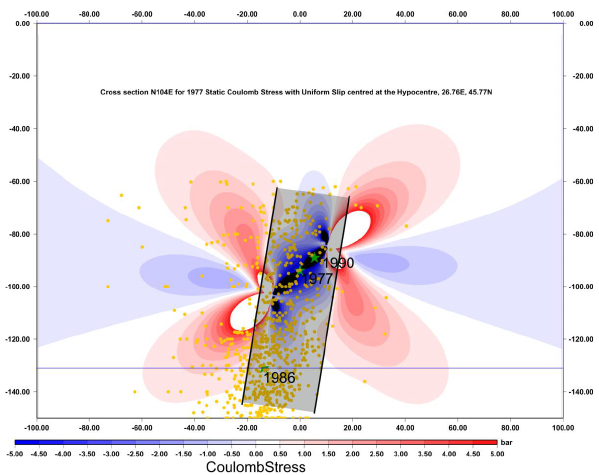
Fig. 7. Cross section of the combined Coulomb stress field due to 1977 and 1986 earthquakes (assuming an effective friction of 0.4). Strike of section is N110 ◦ E. Section centre point is the 1990 hypocentre. Colour palette of stress values is linear in the range of of − 5 to +5bar (1bar=100kPa). Blue areas indicate unloading, red areas indicate loading, respectively. White colour indicates area where transferred stress > 5bar and black colour the area where stress reduction was < − 5bar. Green stars show the earthquake hypocentres. Solid yellow circles are aftershocks (1977–1990). Shaded rectangle indicates shape of Vrancea slab (dip to the